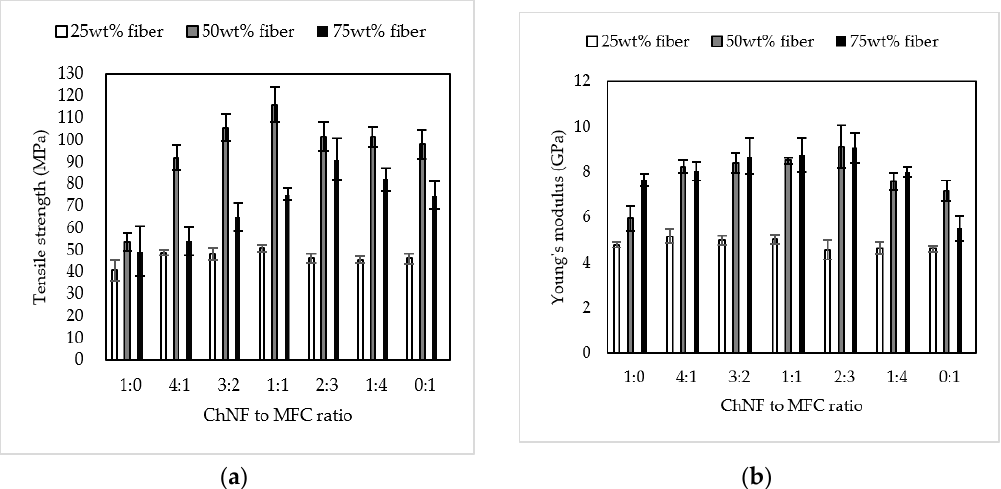
Figure 4. Plots summarizing the data of all composites (reinforcement fraction of 25 wt %, 50 wt %, and 75 wt %) as a function of varying chitin nanofiber (ChNF) to microfibrillated cellulose (MFC) ratios: ( a ) tensile strength; ( b ) tensile modulus.